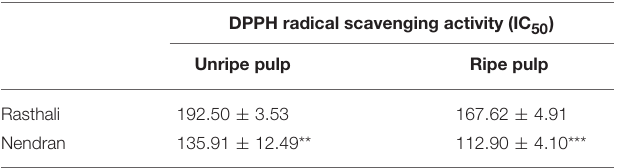
TABLE 4 | Measurement of antioxidant activity in extracts prepared from pulp of Nendran and